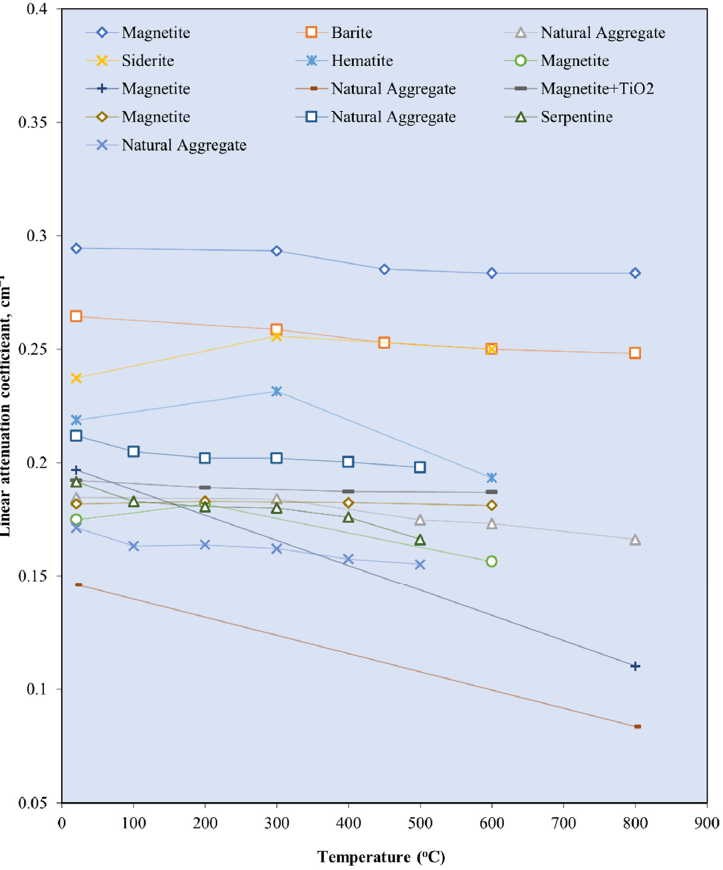
Figure 17. Relationship between linear attenuation coefficient (cm − 1 ) based on 0.662 MeV gamma exposure and temperature (°C) of different types of concrete (data adapted from [16,44,53,67,123]). A comparison of the coefficient of thermal expansion indicates that barite has almost three times the value of the natural aggregate and more than 1.5 times the value of mag- netite [53,121,181]. The expansion of barite created cracks and resulted in a loss in the µ value [121]. For hematite RSC, exposure to 500 °C resulted in a 6.6% reduction in the µ value to 0.198 cm − 1 [182]. This reduction is smaller than that of serpentine and dolomite RSC, which exhibited reductions of 9.4% and 13.1%, respectively, after exposure to 500 °C. Serpentine and dolomite concrete reported a residual µ value of 0.155 and 0.166 cm − 1 , re- spectively. The high reduction in the µ value of dolomite RSC could be attributed to the combustion of organic compounds inside it and water evaporation at a temperature range of 100 °C–600 °C [182]. For serpentine RSC, the reduction in the µ value is due to the loss of bonded water at a temperature of 500 °C because serpentine is a type of hydrated ag- gregate [119]. Goethite, which is another type of hydrated aggregate, also reported a loss of water, which led to a reduced µ value at an elevated temperature. Goethite RSC recorded a 15.6% reduction in the µ value after exposure to 450 °C, which is also a lower residual µ value than that of serpentine and dolomite concrete [67]. This condition is due to the de-hydroxylation and transformation of goethite, which is indicated by the largest weight loss of 11.25% after exposure to 450 °C [67]. The natural aggregate in RSC recorded a 10.3% loss in the µ value due to a crystalline transition, which led to a loss of density and, hence, a reduction in the attenuation property [53].